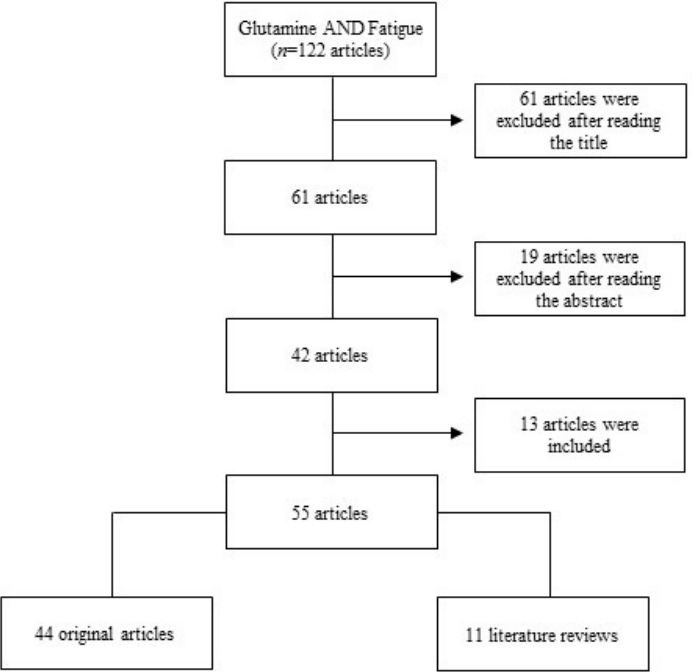
Figure 1. Stages of study—selection and inclusion of articles.